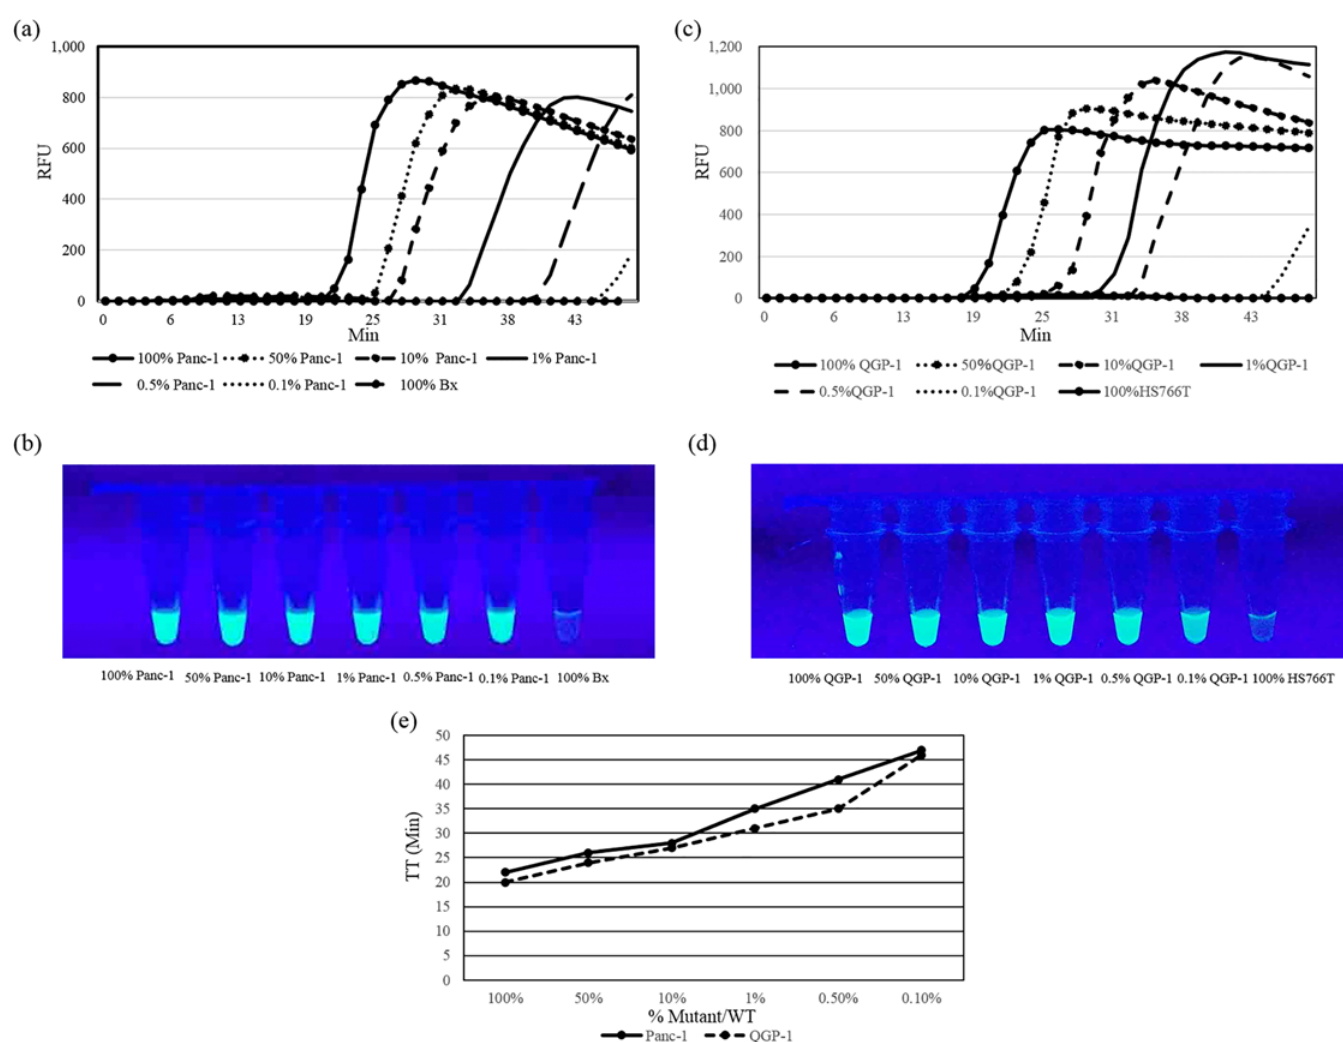
Fig 4. The LOD of PNA-LNA mediated LAMP. Mutant type Panc-1 and QGP-1 samples were serially diluted with wild type Bx and HS766T samples (100% Bx and 100% HS766T) to give Panc-1 and QGP-1 cDNA samples concentrations of 100, 10, 1, 0.5, 0.1 and 0%, which were then analyzed using PNA-LNA mediated LAMP. As a negative control, we use 100% Bx and 100% HS766T cDNA samples. (a, c) The graph shows the fluorescence intensity of LAMP products measured using real-time PCR equipment. (b, d) The fluorescence emitted by LAMP products in microtubes under UV light was visually assessed. (e) The graph shows the respective graph of TT vs %Mutant/ WT for both mutations. The TT value was defined as the time it took for fluorescence intensity to reach a threshold value of 100 after baseline